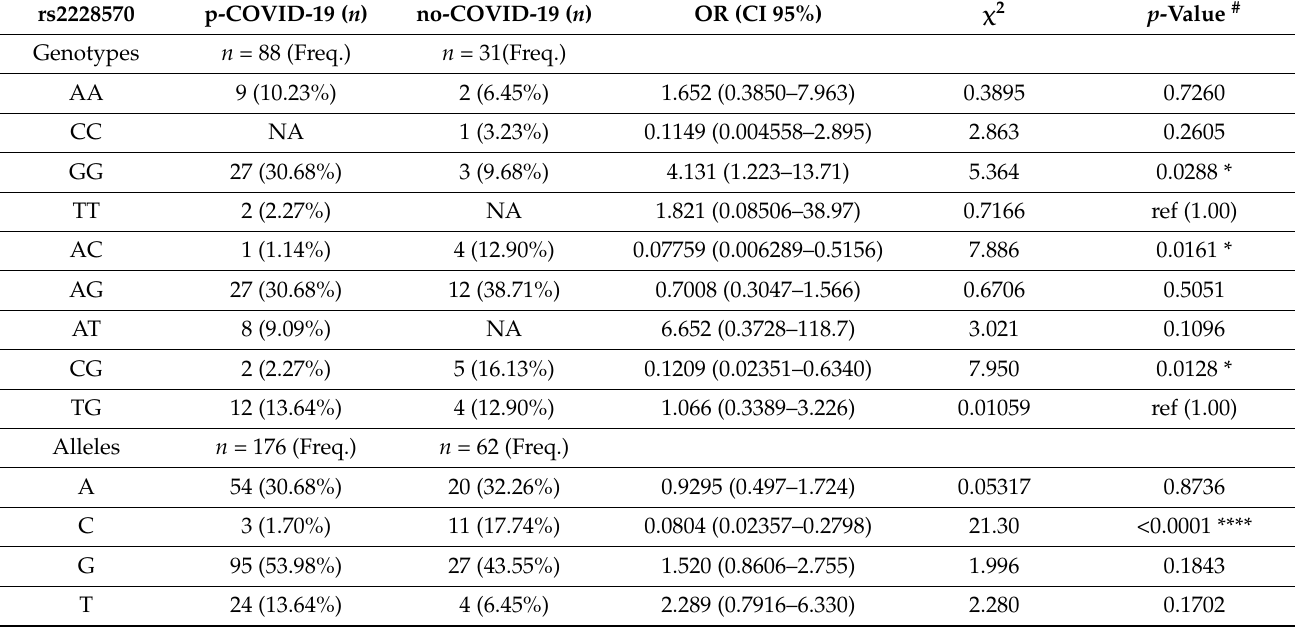
Table 2. rs2228570 allele and genotype frequencies in p-COVID-19 and no-COVID-19